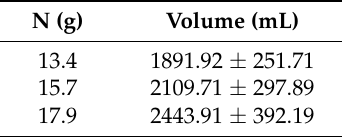
Table 4. Total volume of parenteral nutrition in relation to nitrogen content (mean ±